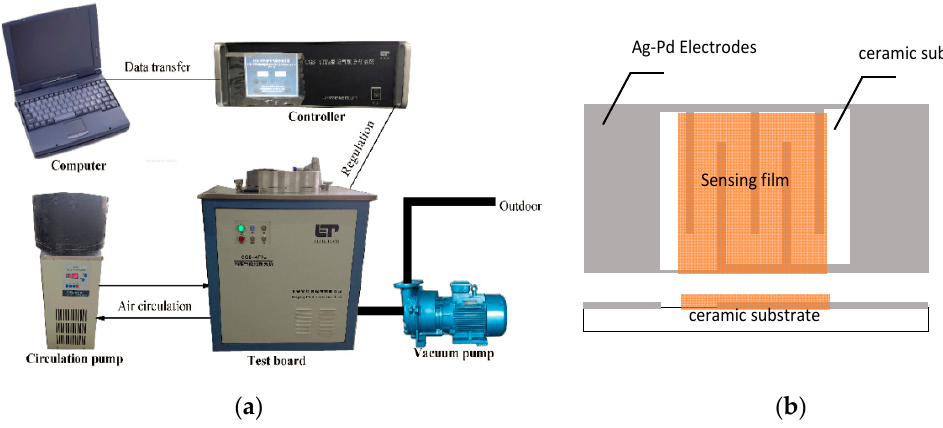
Figure 1. ( a ) The CGS-4TPS gas-sensing test system and ( b ) the gas sensor substrate.